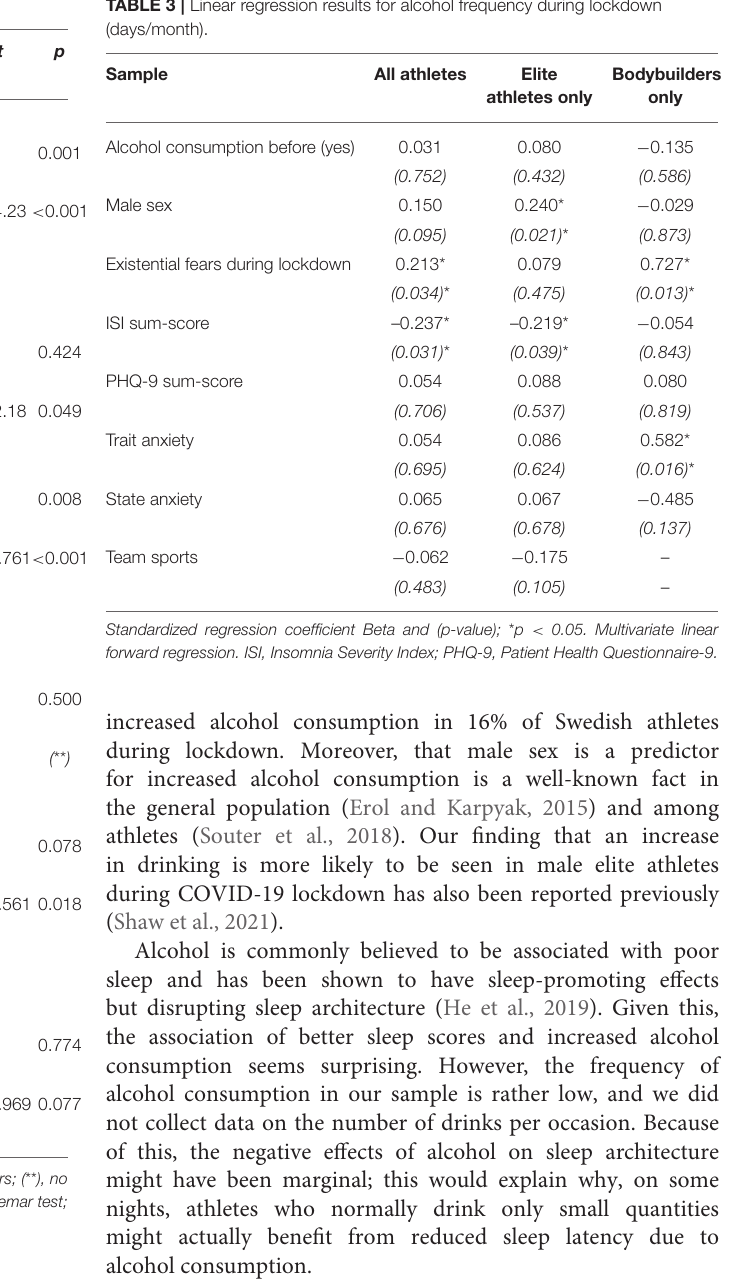
TABLE 2 | Alcohol and cannabis use. TABLE 3 | Linear regression results for alcohol frequency during lockdown